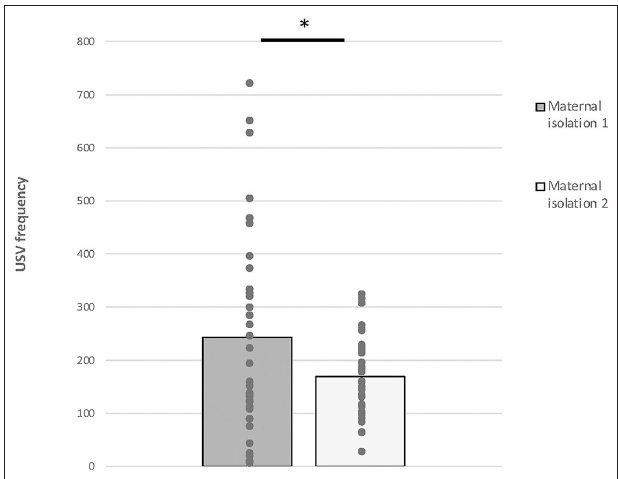
FIGURE 3 | Maternal isolation-induced pup USV test. Total numbers of USVs emitted by PND 7 mice (data from anophthalmic and sighted mice were compiled) during the 5-min isolation 1 and the 5-min isolation 2 (mean ± SE; * p <